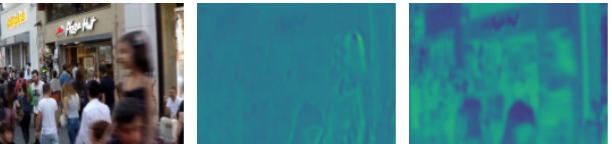
Figure 1. The feature map of disentangle branches for local and global blur feature maps. From left to right are the blurry image, local blur feature map, and global blur feature